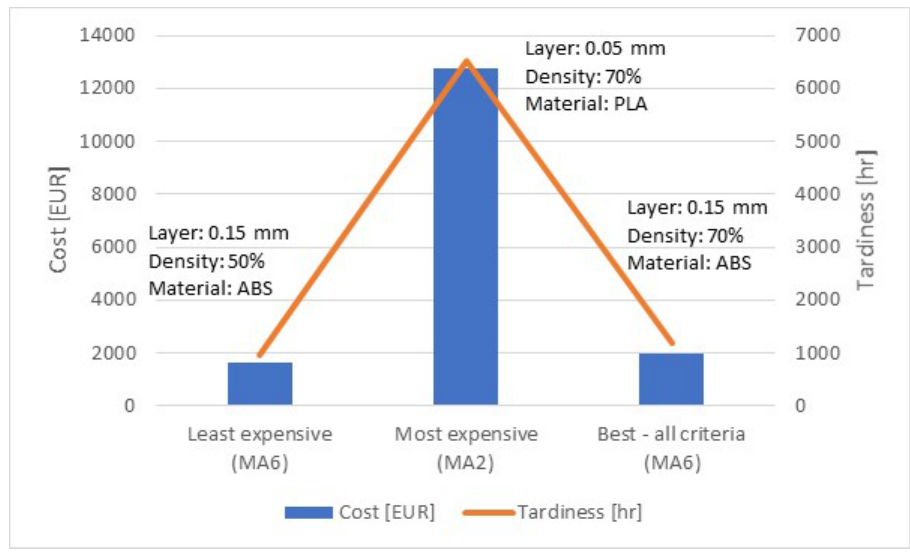
Figure 11. Test Case 2—Design Agent GUI with technical data and information from Machine Agents.